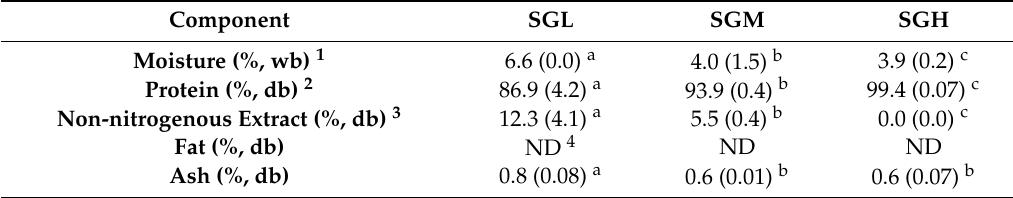
Table 1. Proximate composition of salmon gelatin samples used in this study. SGX, X = molecular weight defined by pH used during extraction process. Values in brackets correspond to standard deviation (n = 3).